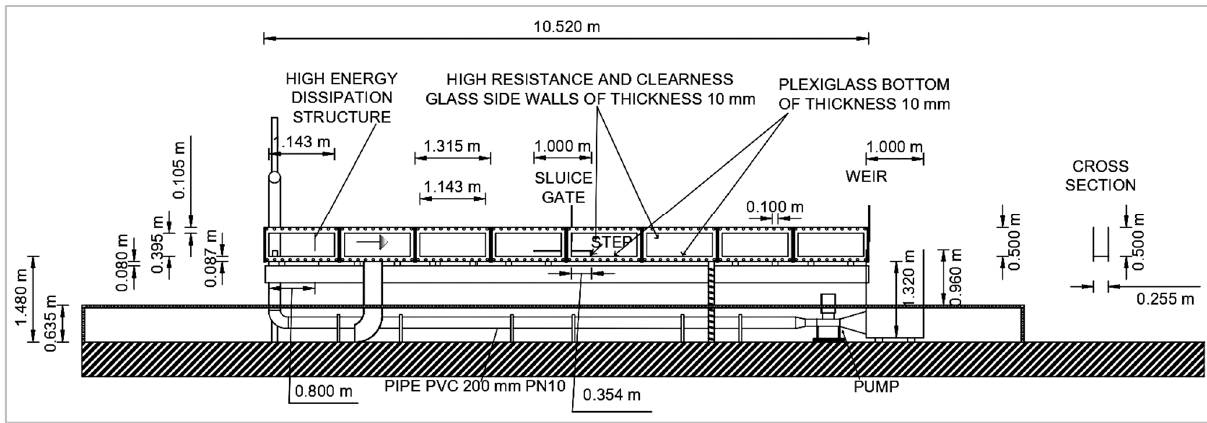
Figure 3. Side view of the open channel.